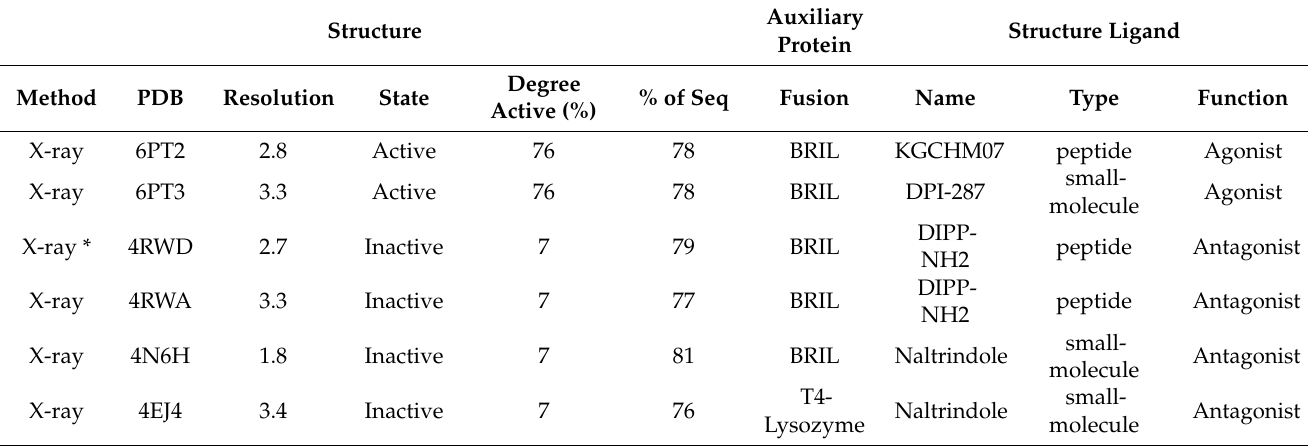
Figure 1. Resolved structures of the δ OR in complex with small molecules and peptides. Schematic depiction of the small molecule agonist DPI-287 and antagonist naltrindole and the peptide agonist KGCHM07 and antagonist DIPP-NH2 bound to the δ OR (Top panels; active-like structures in yellow and inactive structures in sea green). The difference in TM domain positions between the antagonist- and agonist-bound structures (Lower panels; antagonist-bound in grey and agonist bound in hot pink). TM domain positions produced using the structure comparison tool from GPCRdb. Table 1. Overview of resolved x-ray crystal structures of the δ OR. Table produced using the